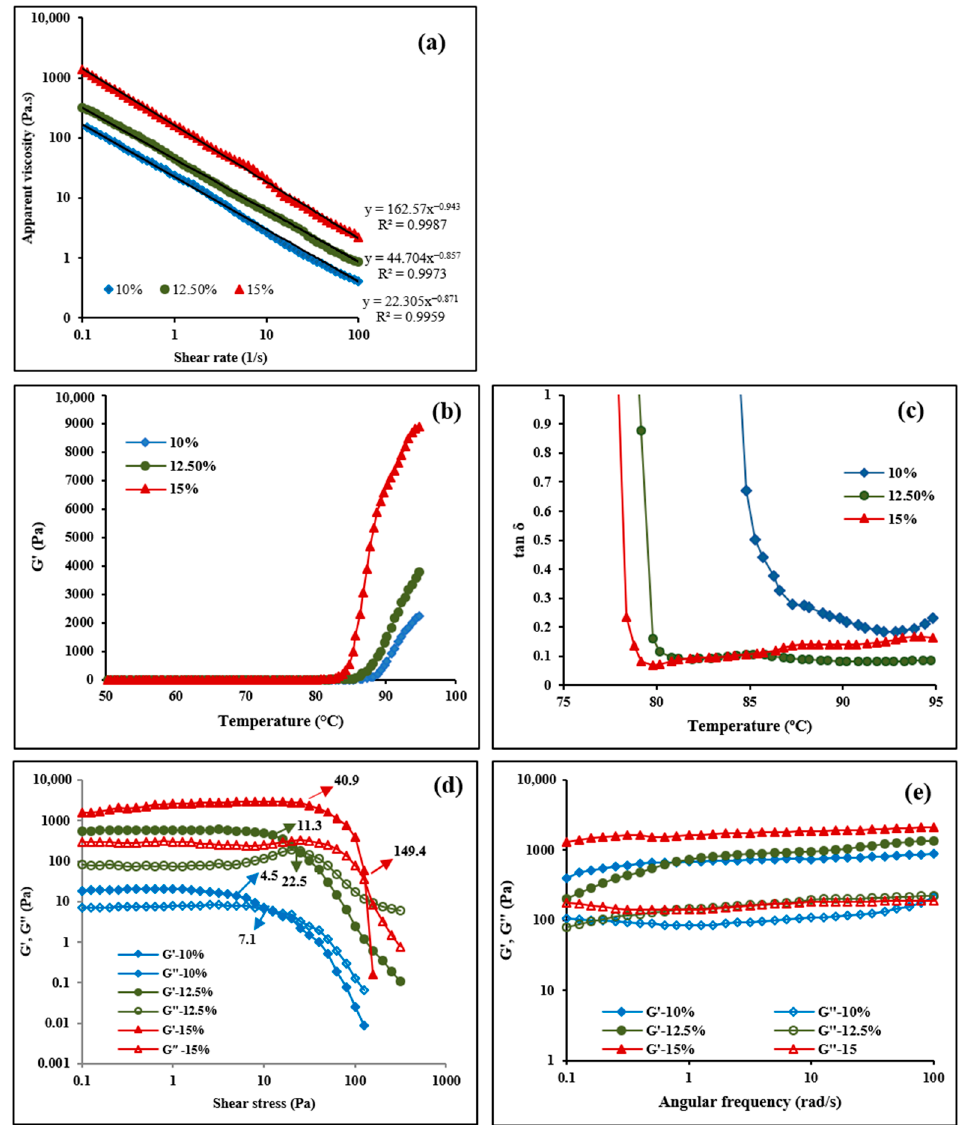
Figure 9. ( a ) Viscosity as a function of shear rate at 95 °C; ( b ) G ′ and ( c ) tan δ versus temperature; ( d ) stress; and ( e ) frequency dependence of G ′ and G ″ for starch suspensions at various concentrations.